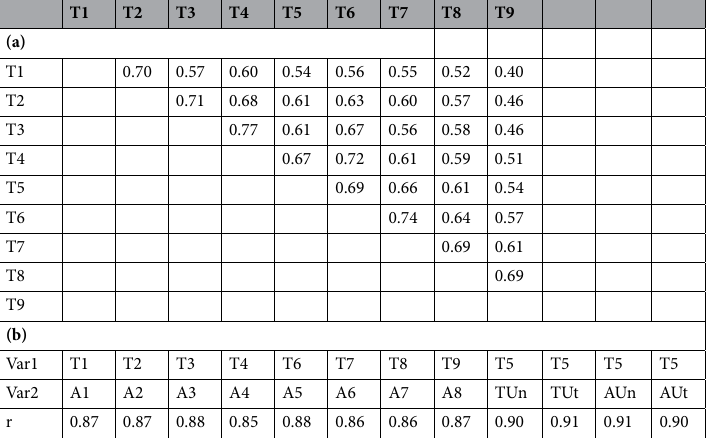
Table 1. Pearson correlation coefficients (A) among thickness coefficients and (B) between thickness and area/nulla sub-analysis coefficients. Var1 variable 1, Var2 variable 2, r Pearson correlation coefficient.